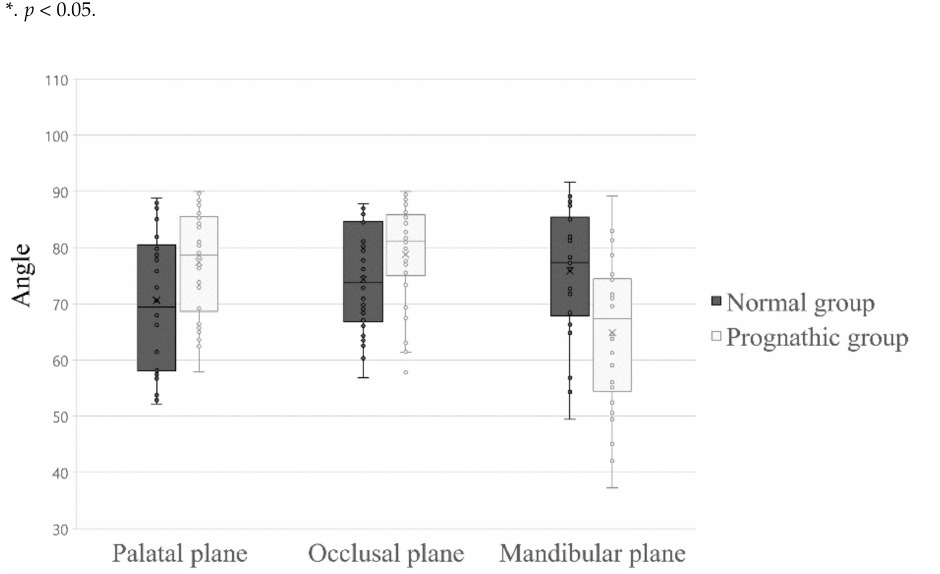
Figure 6. The distribution of the angle of deep masseter muscles to three planes: palatal, occlusal, and mandibular. Angles to palatal and mandibular planes showed significant differences. The participants of the normal group had a more vertical angle to the mandibular plane than those of the prognathic